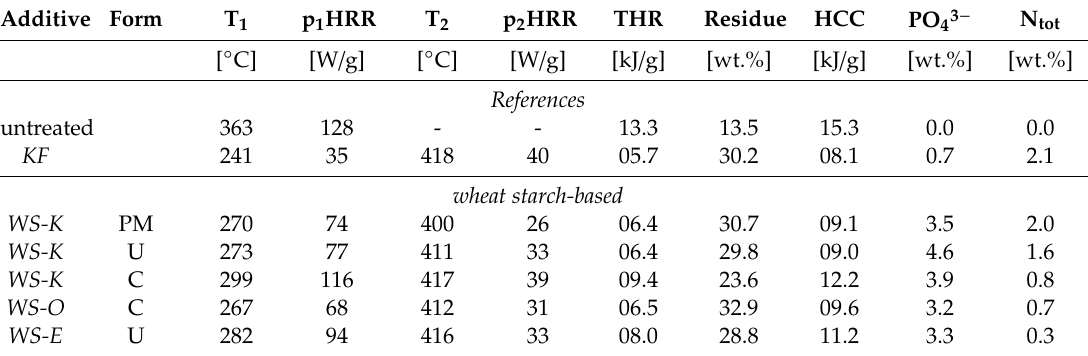
Figure 8. Heat release rate curves from PCFC measurements of untreated wood fibers without additive, with commercial flame retardant KF and starch-based FR WS-K and WS-O in form of physical mixture, uncleaned and cleaned synthesis product. Table 6. Results from the pyrolysis-combustion flow calorimetry, test matrix wood fiber, additive content 10